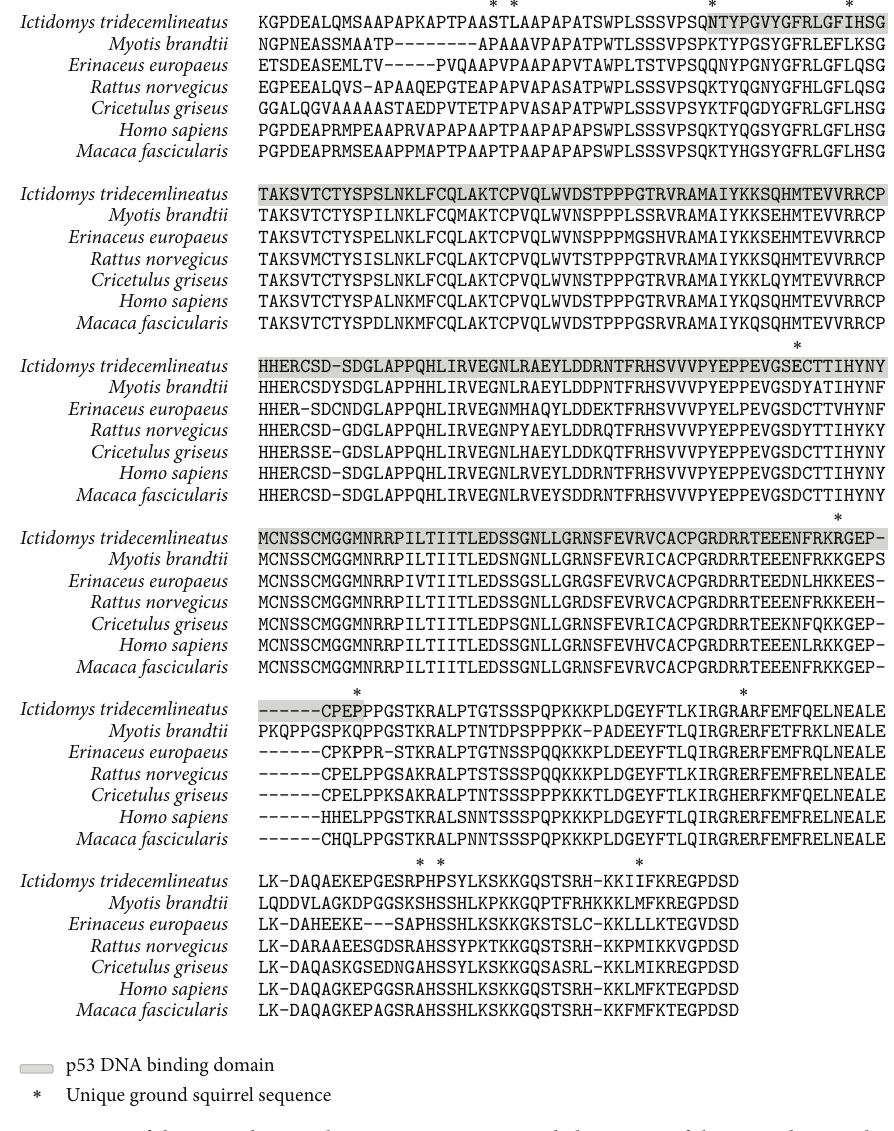
Figure 5: Sequence comparison of the ground squirrel p53 protein. Amino acid alignments of the ground squirrel p53 protein with other hibernating and nonhibernating mammals. ∗ denotes unique substitutions in the ground squirrels at amino acid residues that are conserved among other nonhibernating mammals; residues shaded in grey indicate p53 DNA binding domain.